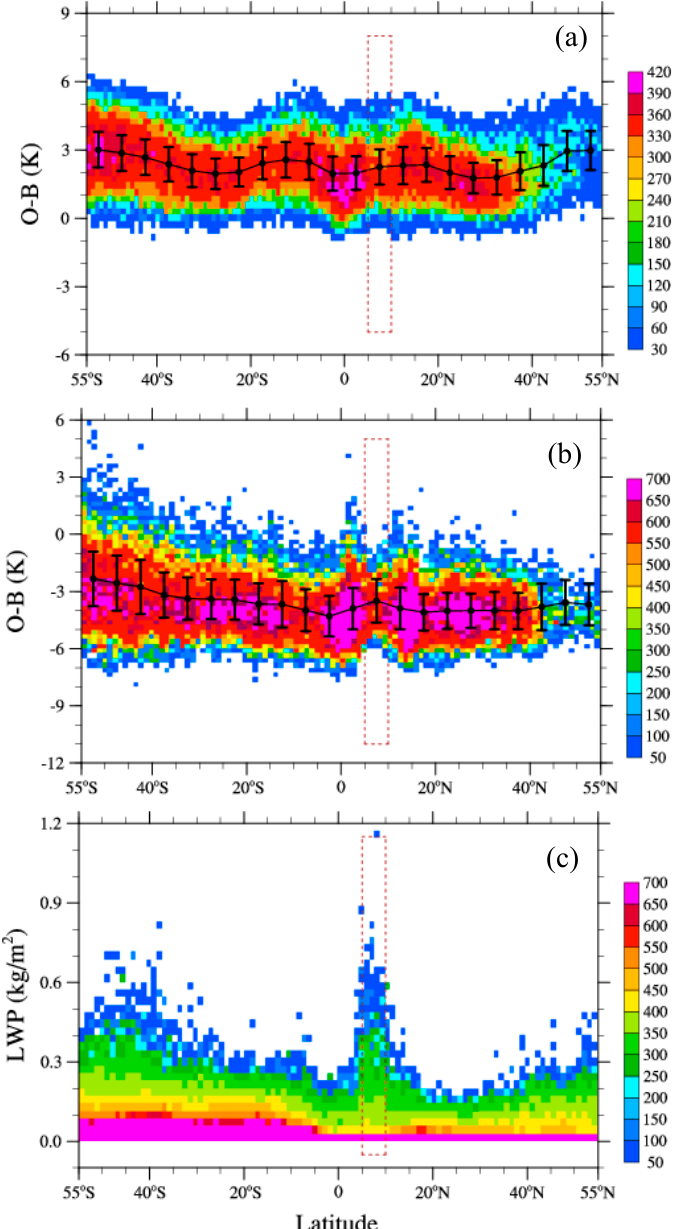
Figure 5. Data counts of clear-sky O-B at nadir over oceans for ( a ) AMSU-A channel 1 and ( b ) FY-3C MWTS-2 channel 1 collocated with AMSU-A ( < 100 km, < 1.5 h). ( c ) Liquid water path (LWP) from 1 July to 14 July 2014. Mean and one-standard deviations are indicated by black curves and black vertical lines, respectively. The brown dashed boxes show the intertropical convergence zone.